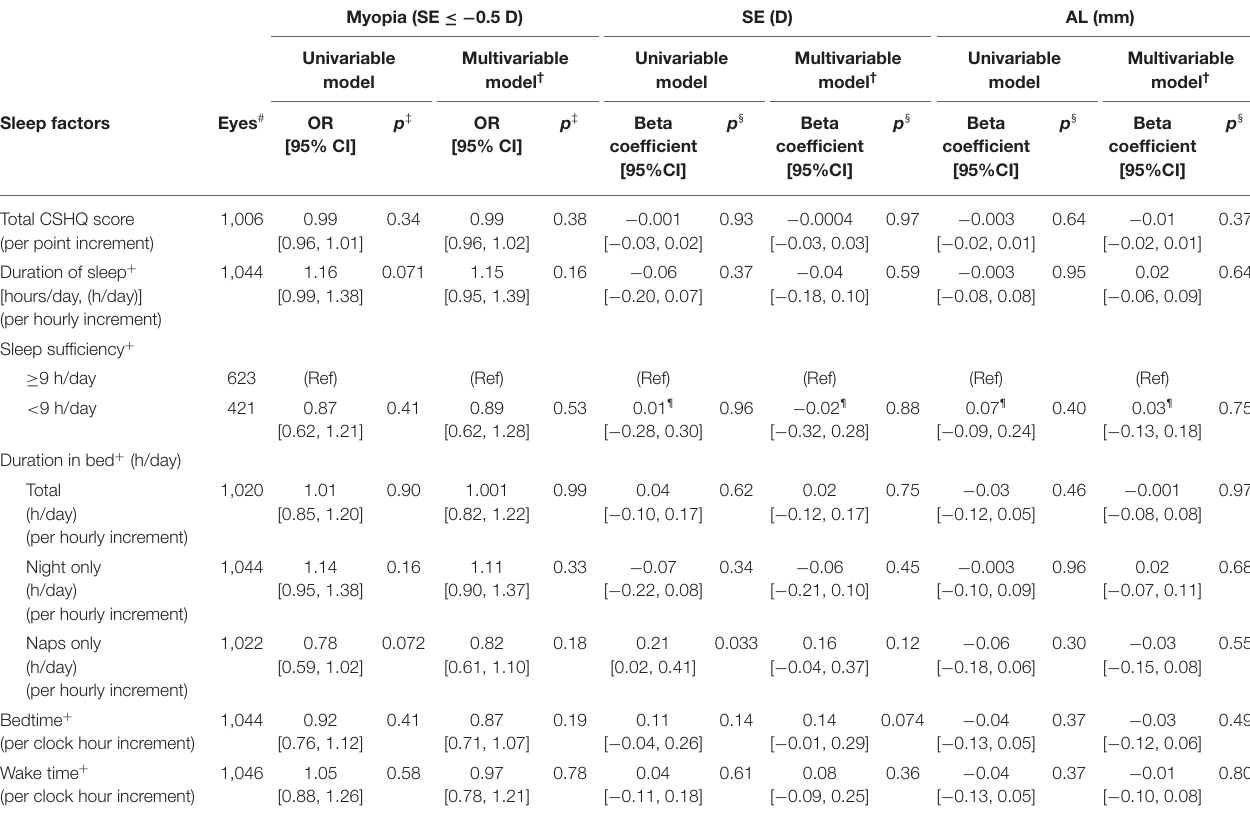
TABLE 2 | Associations of sleep factors with myopia (SE ≤ − 0.5 D), spherical equivalent (D) and axial length (mm) in children from the Growing Up in Singapore Towards healthy Outcomes (GUSTO) cohort ( n =